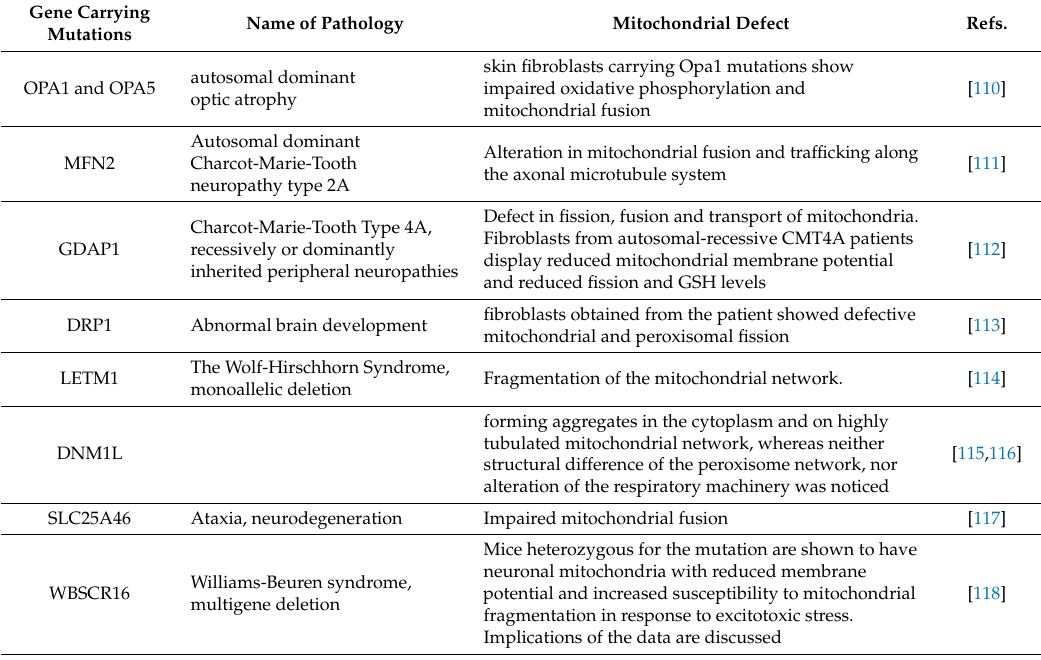
Table 1. Human disorders associated with disturbed mitochondrial